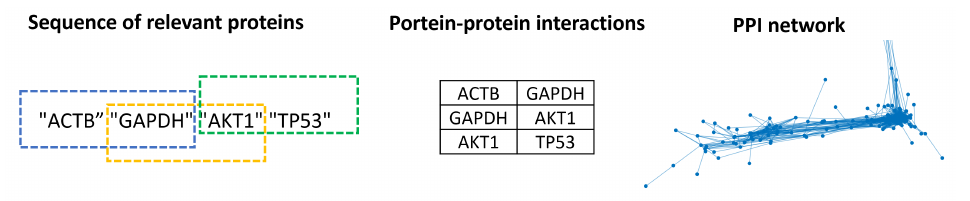
Figure 7. Detection of spurious PPIs in relevant node sequences.